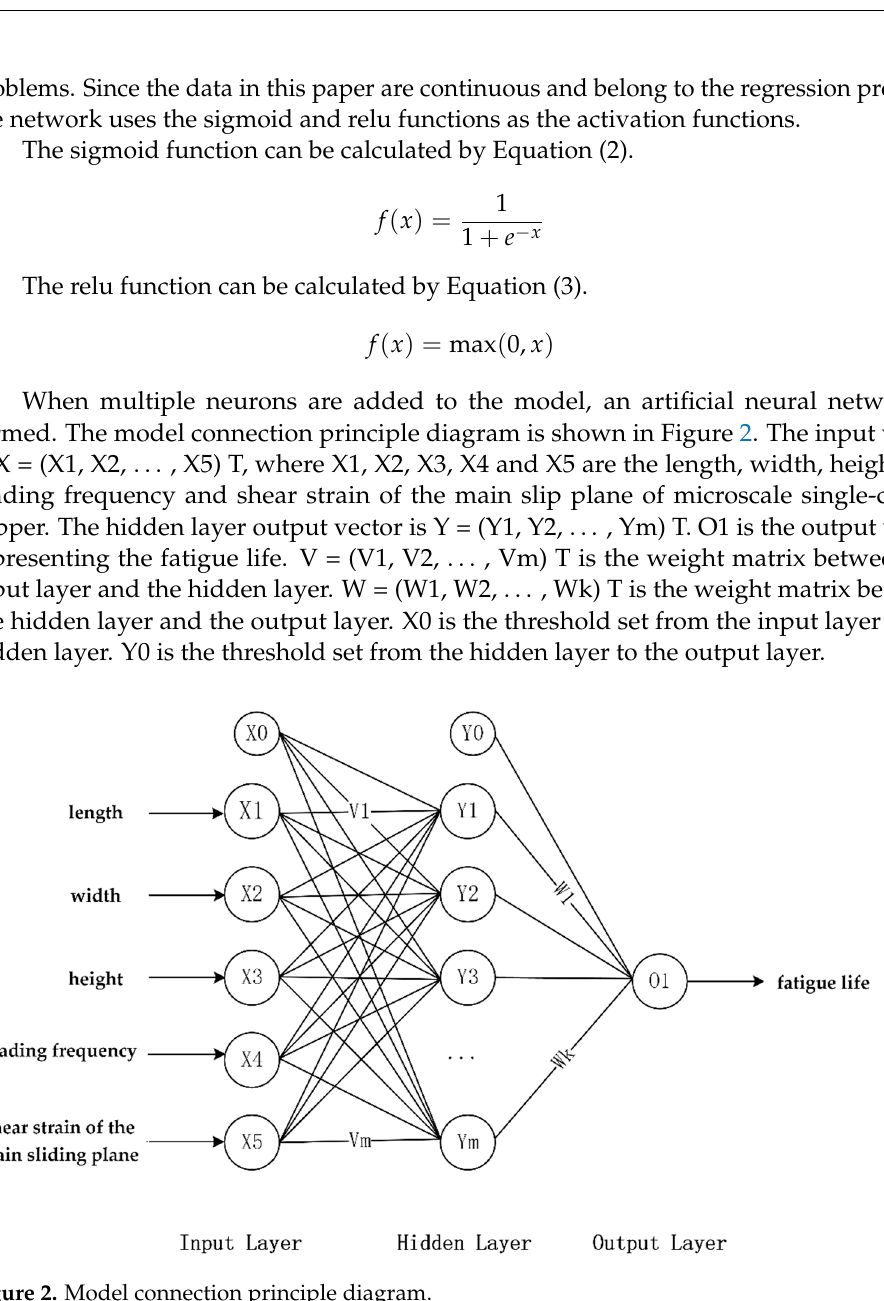
Figure 2. Model connection principle diagram.